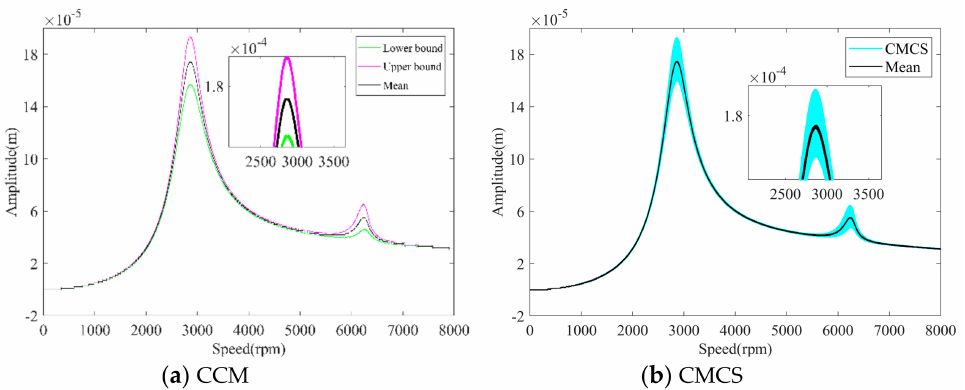
Figure 7. Deflection of the dual-disk rotor with damping uncertainty. Compared with CMCS, the response boundary in the critical speed range calculated by CCM is similar, and the deterministic transient response curve of the system is symmet- rically shifted up and down. The resonance peak position does not change and falls within the critical speed